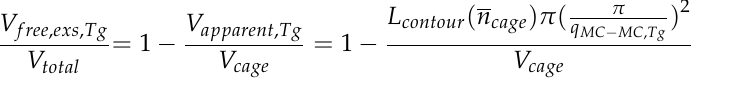
Figure 3. Number distributions of chains ( a ) and monomers ( b ) in “static cage” at 393 K . The black bars represent the monomers at the end of the chain, while the red bars represent the monomers in the middle. The cut-off for the monomers at the end of the chain was 12.5 Å, and for the monomers in the middle was 13.7 Å.